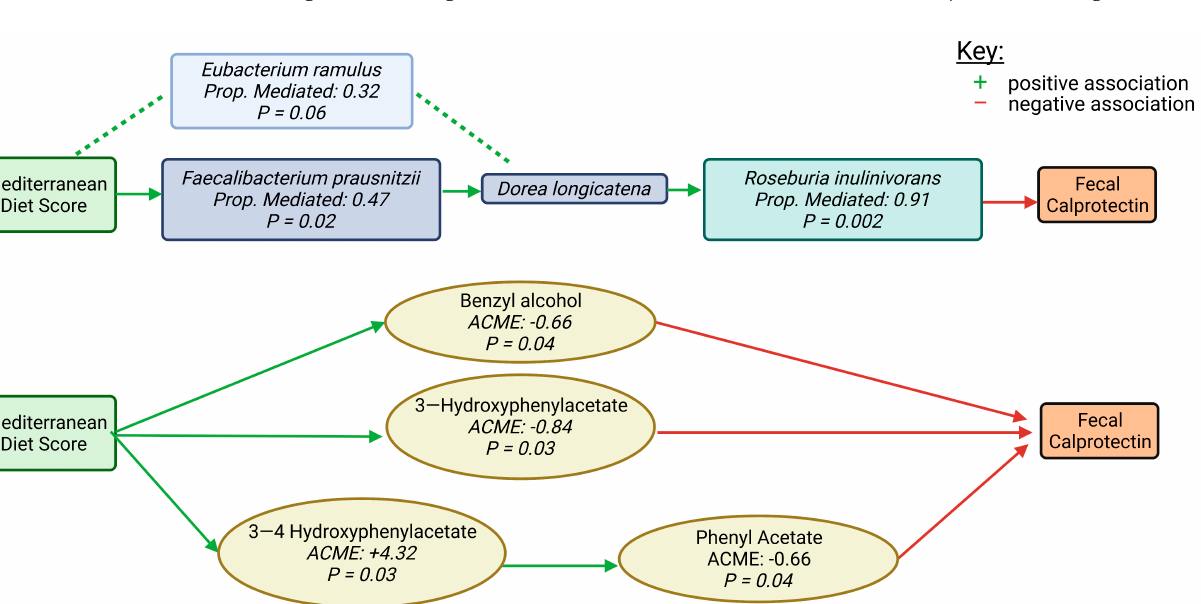
Figure 8. Weighted gene co-expression network analysis (WGCNA). ( A ) A specific health-associ- ated microbiome guild of four taxa significantly influences the association between Mediterranean